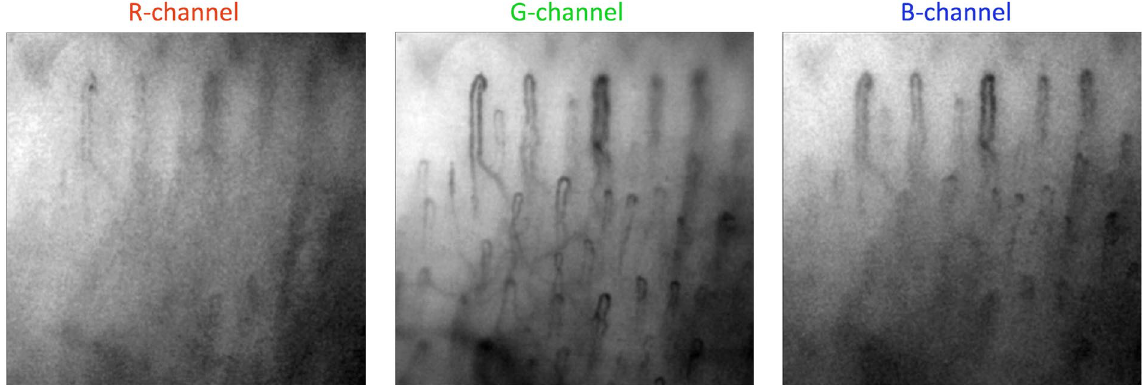
Figure 2. RGB components of the microscopic image of capillaries. The colour version of the image is shown in Fig. 1a.